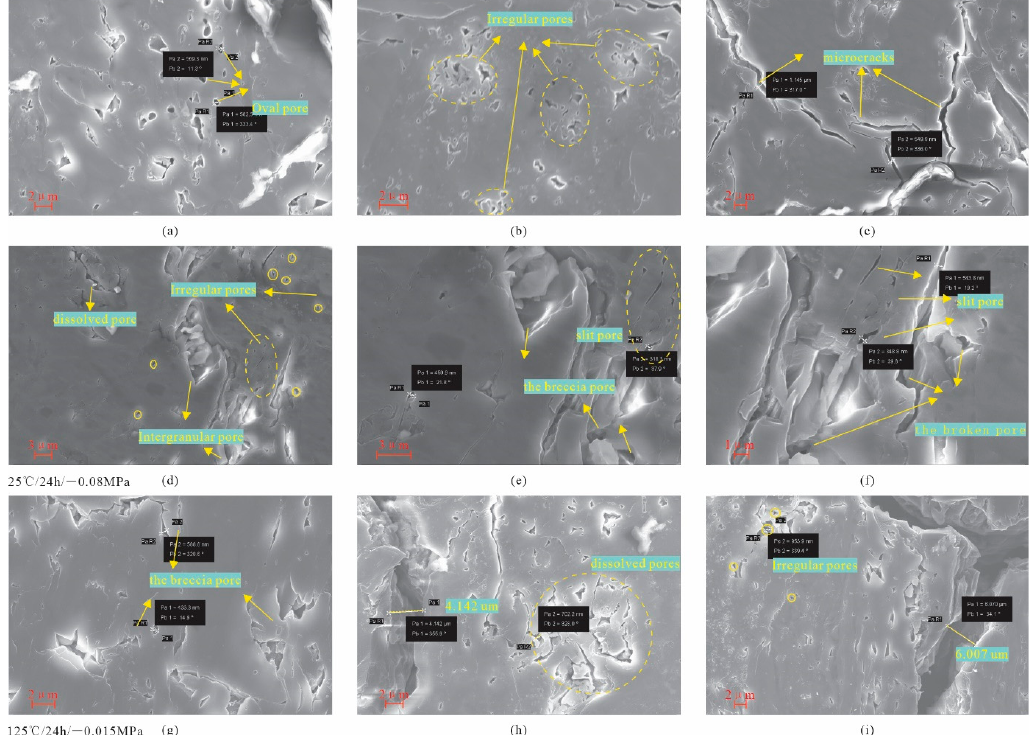
Figure 2. ( a – i ) Characteristics of microporous fractures of low-rank coal from the study area under a scanning electron